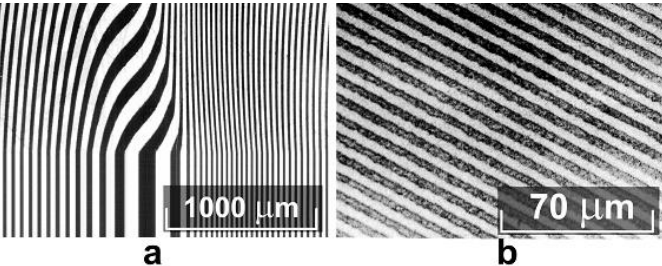
Figure 7. Growth domain structure of a LiNbO 3 :Gd (0.44 wt.%) crystal in a plane perpendicular to the growth axis. ( a ) Panorama; ( b ) growth domain structure at the periphery of the plate.